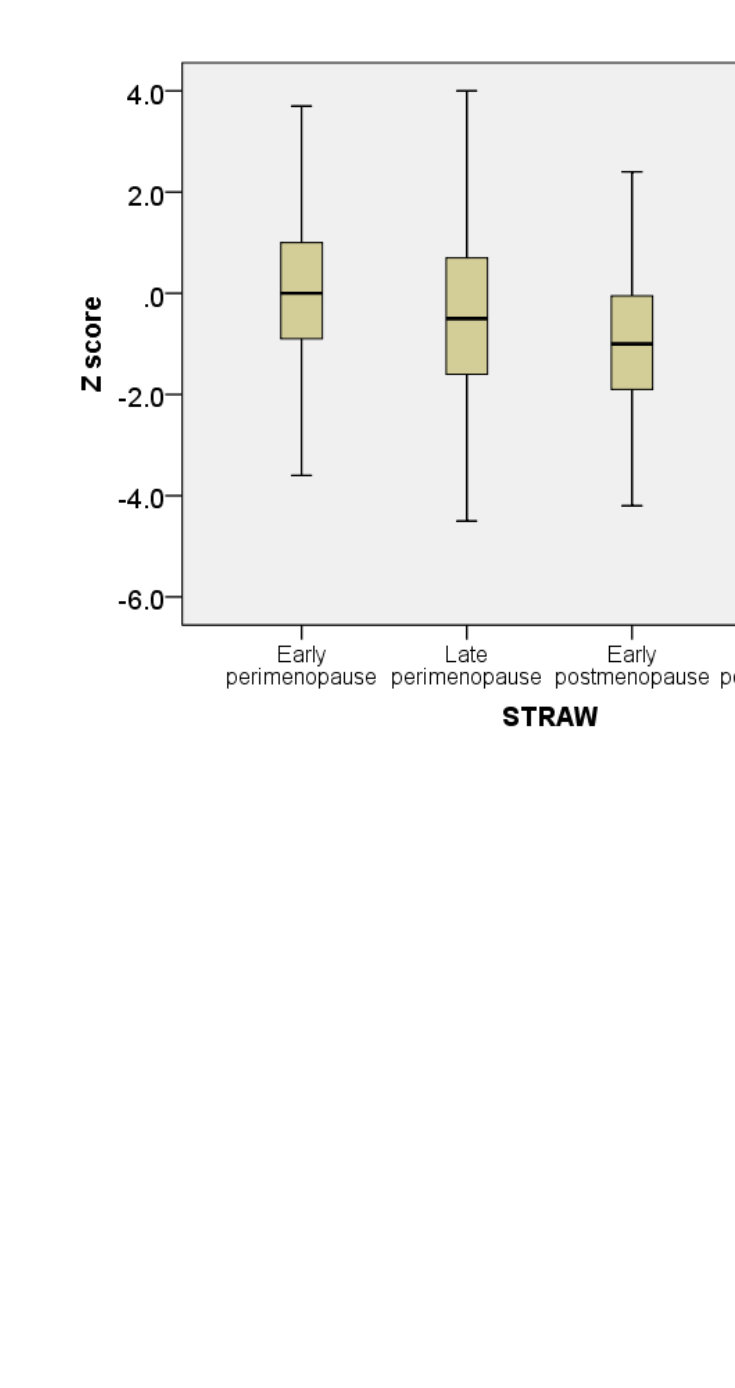
Figure 4. Box plots of Z scores stratified by menopausal